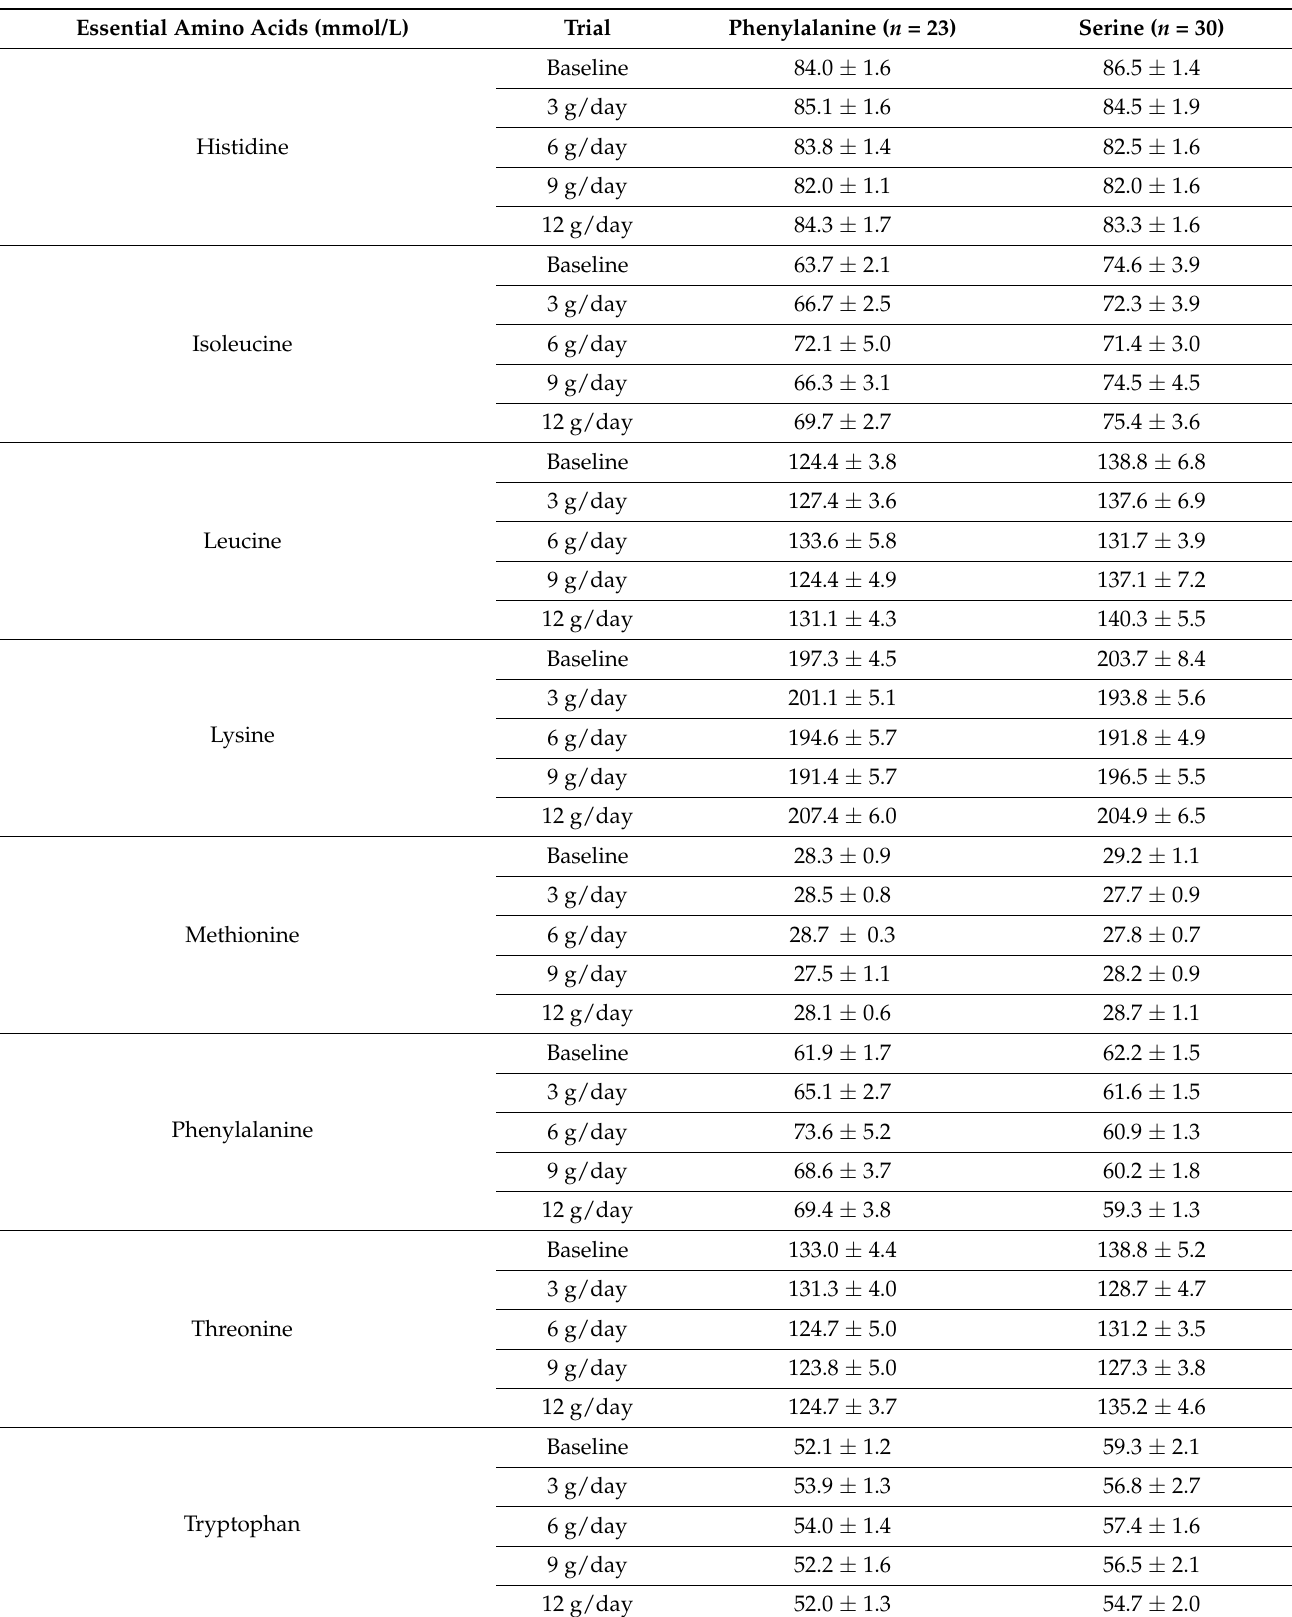
Table 2. Changes in plasma free amino acid levels throughout the oral phenylalanine or serine supplementation period in healthy